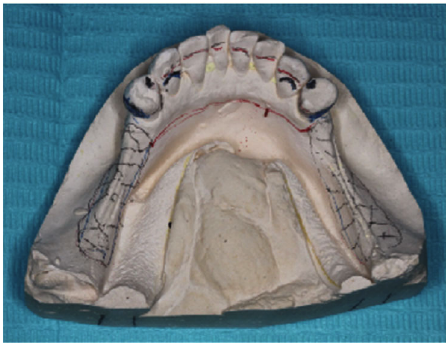
Figure 16: Refractory cast with wax up for chrome cobalt framework.